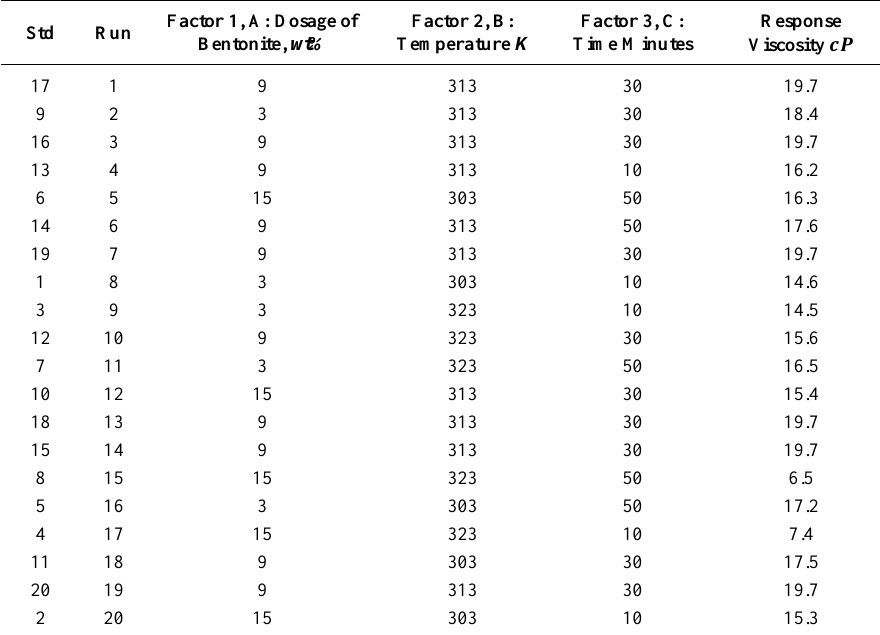
Table 4. RSM results of viscosity of OBMB